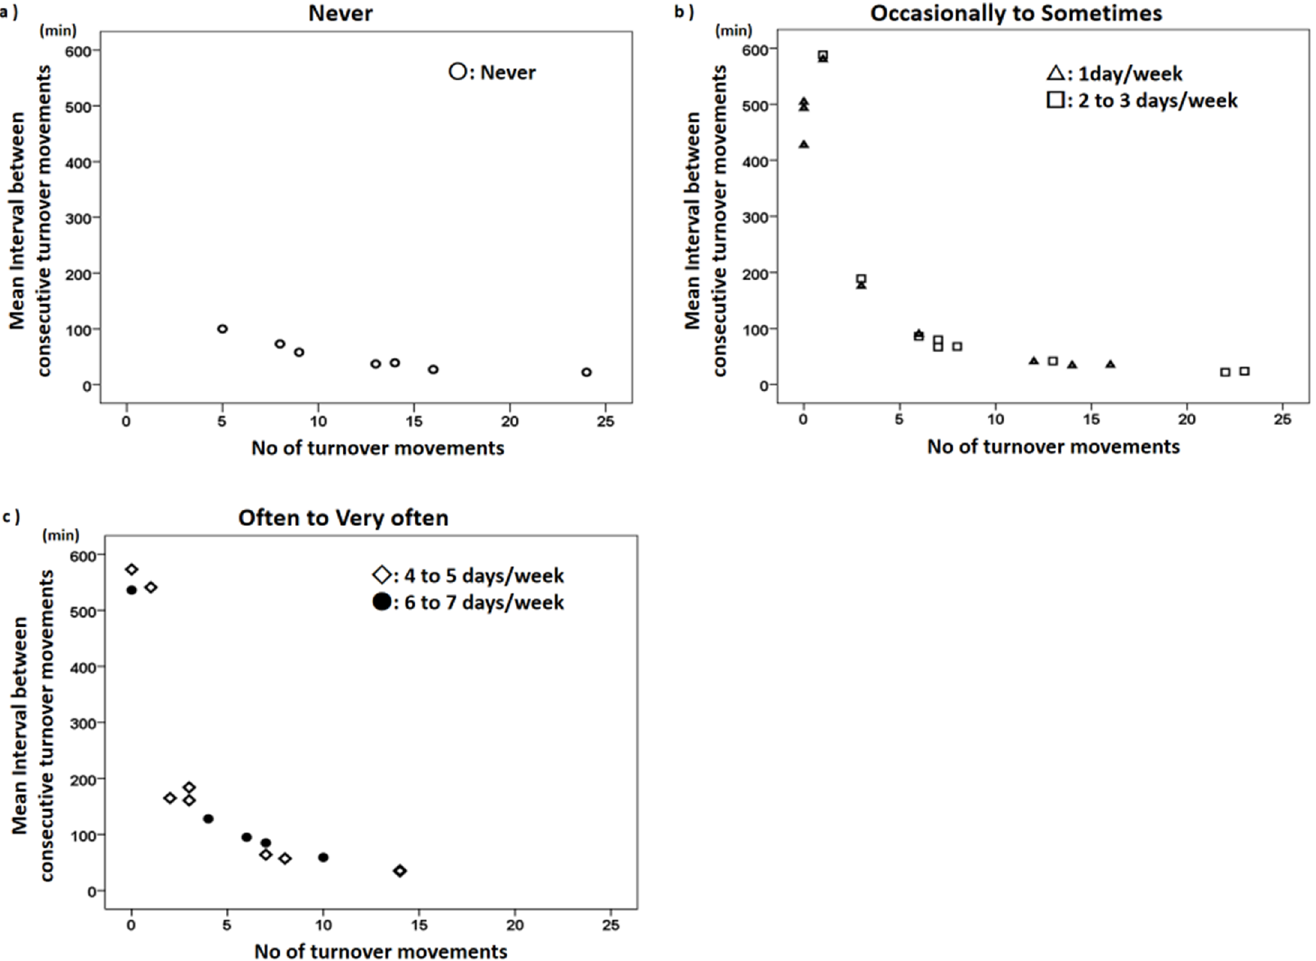
Fig 4. Subjective scoring of discomfort and immobility in bed as evaluated by PDSS-2 Item 9 and objective numbers of overnight turnover movements. Mean intervalbetweenconsecutiveturnovermovements(minutes) as plotted againstnumber of turnover movements in scattergrams by subjectivescores as evaluatedby PDSS-2 item 9: never aware of impairment of turnovermovement (a); occasionally to sometimes (b); and often to very often (c). In patients with no subjectivecomplaint,numberof turnover movements overnight was (cid:21) 5 and mean interval betweenconsecutive turnovers was < 100 min (a). Among patients showing > 5 turnover movements, variousPDSS-2 Item 9 scores rangingfrom 0 to 4 (“never” to “very often”) were